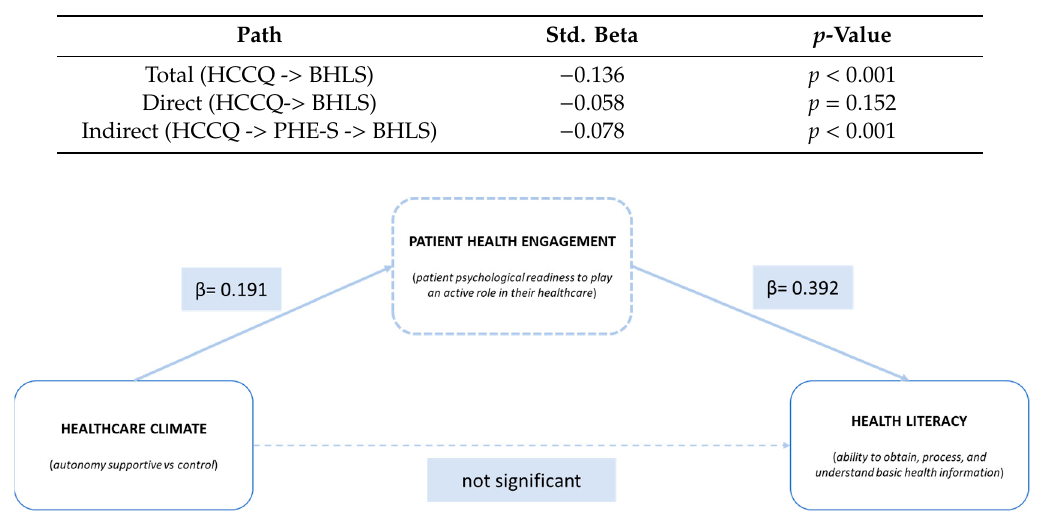
Figure 2. Results of structural equation modeling analysis: the full mediation effect of patient health engagement on healthcare climate in health literacy.